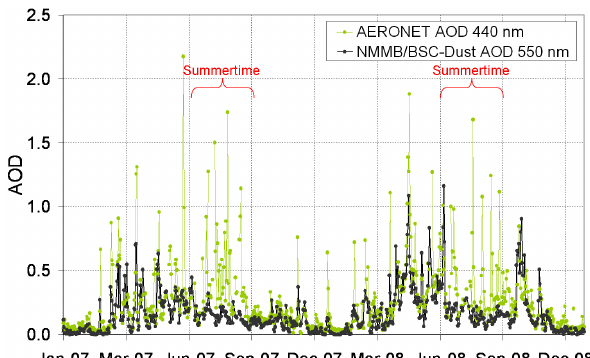
Figure 11. AERONET (green dots) and NMMB/BSC-Dust (black dots) AOD daily mean values for the period